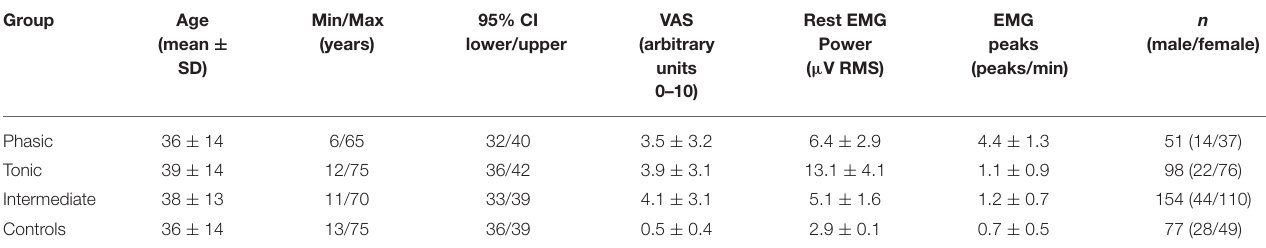
TABLE 1 | Descriptive statistics of the study participants.